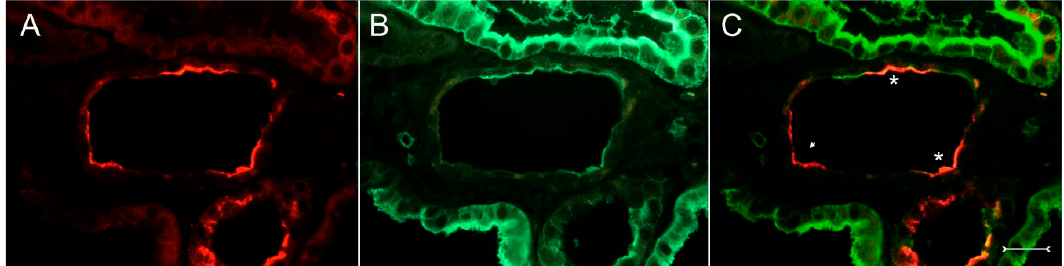
Figure 5. Double fluorescence immunohistochemistry with anti-Kim-1 (( A ), red) and anti-aquaporin-1 antibodies (( B ), green); merged view in ( C ). Kidney cortex of a (cy/+) rat. Differentiated proximal tubules do only express aquaporin-1 in their well-developed brush borders (top in ( B )), while in a cystically-transformed tubule with more flattened cells, Kim-1 expression in the apical cell compartment overlaps with still present, but reduced aquaporin-1 staining (examples are marked with asterisks). Kim-1 is also expressed in cells devoid of aquaporin-1 (see small arrow). At the bottom, a normal-sized tubule also demonstrating partial overlap of Kim-1 and aquaporin-1 staining. Bar = 25 µm.